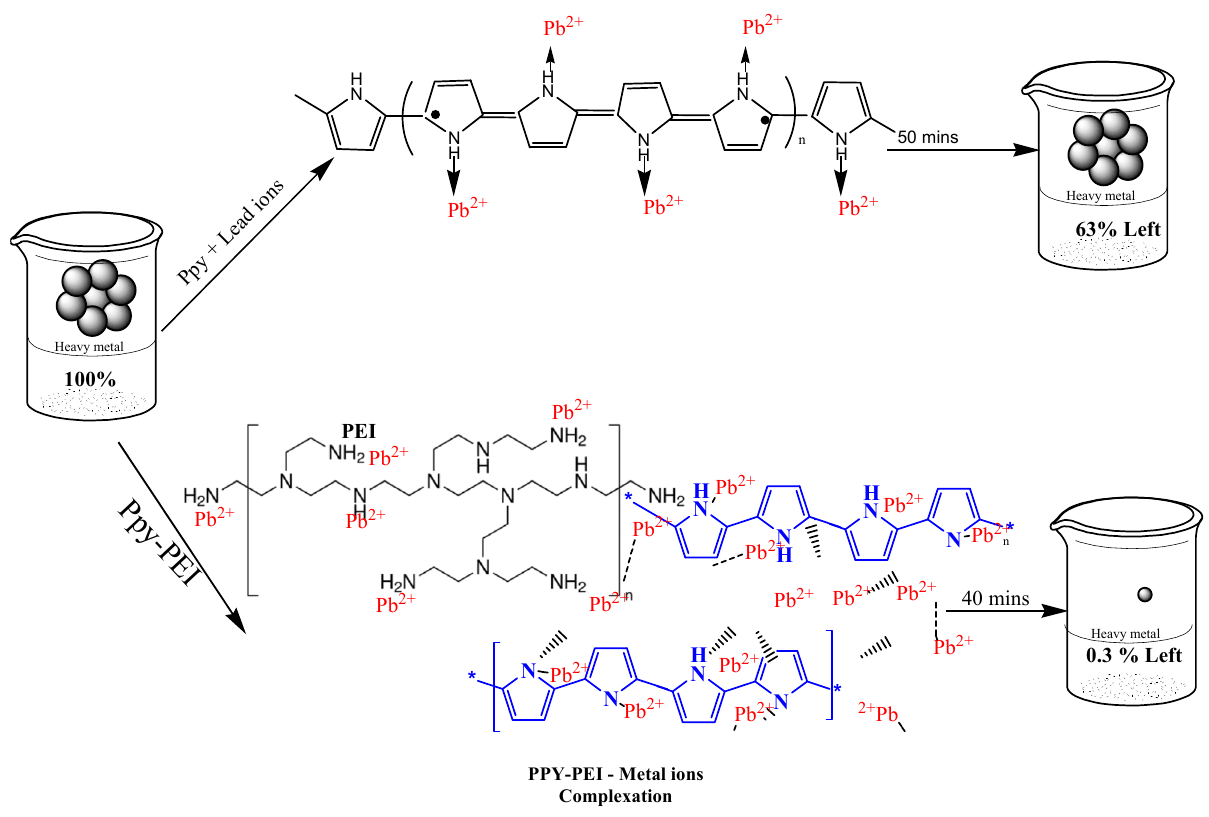
Figure 1. Schematic diagram of adsorption of polypyrrole and polypyrrole ‐ polyethyleneimine.